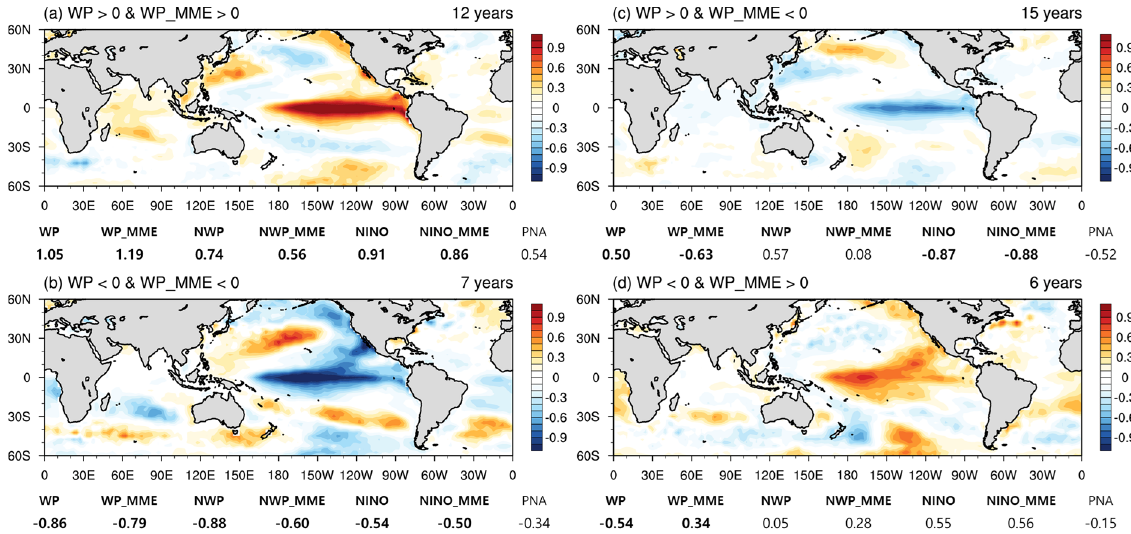
Figure 14. Composites of SST for the years of correct predictions of ( a ) positive WP, ( b ) negative WP, and incorrect predictions of ( c ) positive WP and ( d ) negative WP. The averages of the corresponding years observed and predicted index anomalies are shown under the panels. Significant at the 95% confidence level index anomalies are typed in bold.